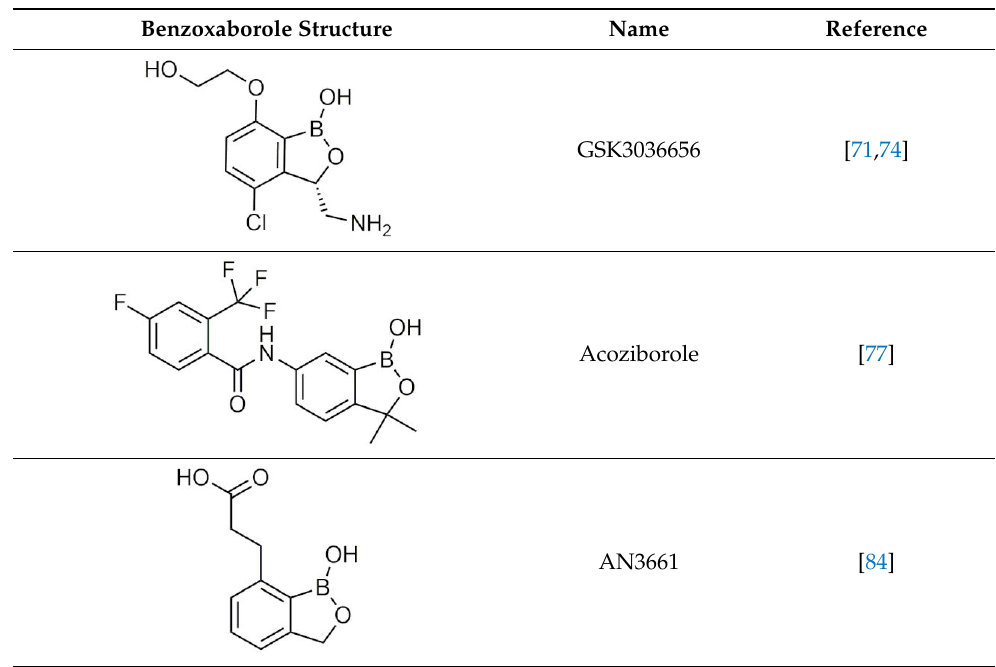
Table 3. Benzoxaborole medicinal